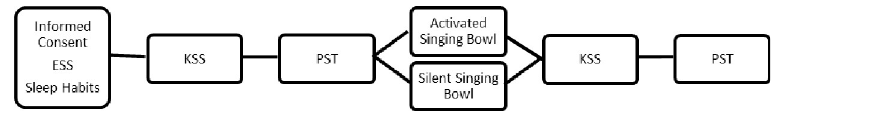
Fig 1. Course of the study